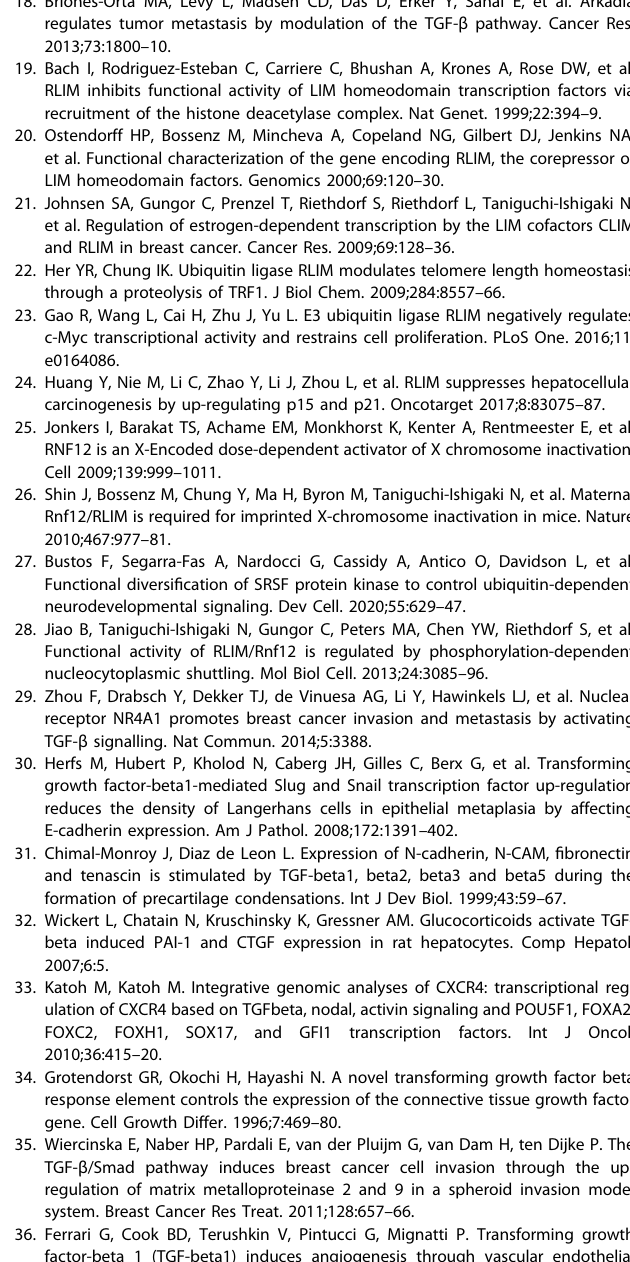
Fig. 6 AKT signaling increases TGF- β /RNF12 signaling and related metastasis. A Control and RNF12 stably depleted MDA-MB-231 cells were plated for the cell wound-healing assay. Sub-con fl uent MDA-MB-231 cells were wounded using a 20 µL pipette tip and treated with or without the indicated ligands and reagents for 16 h. The wound-healing area at 16 h after wounding was normalized to that at the start time. B Statistical analyses were performed with Student ’ s t -test (*0.01 < p < 0.05; **0.001 < p < 0.01; *** p < 0.001). For the bar charts, data are plotted as the mean ± SD of at least three independent experiments. C Immunoblotting analysis of mesenchymal marker expression treated with IGF- 1, TGF- β , and MK2206 as indicated. D RNF12 depletion inhibits AKT- and TGF- β -induced EMT in MDA-MB 231 cells. Cells were treated with TGF- β for 24 h. F-actin was stained with phalloidin conjugated with tetramethylrhodamine isothiocyanate (TRITC). E Representative images of RNF12 and matched pAKT and pSMAD2 immunohistochemistry results are shown. Graphs in the right panel show the correlation between RNF12 expression levels and those of pSMAD2 in breast cancer TMAs. Spearman ’ s test was used, and the correlation coef fi cients and the two- tailed signi fi cance values ( p < 0.001) are shown. Scale bar = 300 μ m. F Proposed model for the crosstalk between AKT signaling and RNF12 in breast cancer